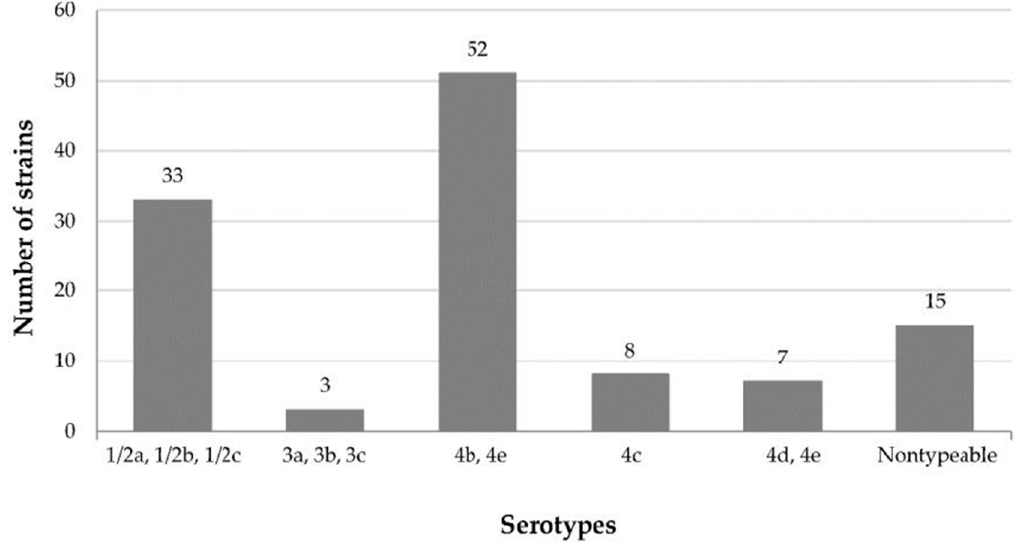
Figure 1. Serotyping for 118 L. monocytogenes isolates from red meat and poultry in Spain.